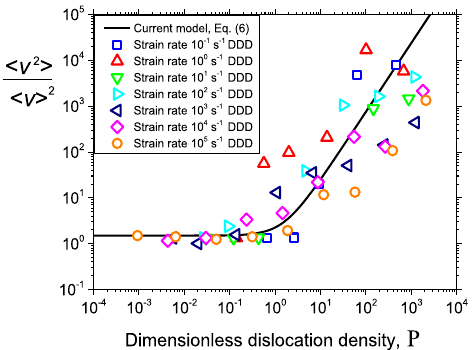
Fig. 6 Squared variation coef fi cient of the dislocation velocity distribution in DDD simulations. Symbols are datasets for different strain rates and full line is the theoretical prediction of Eq. (6). DDD is abbreviation of discrete dislocation